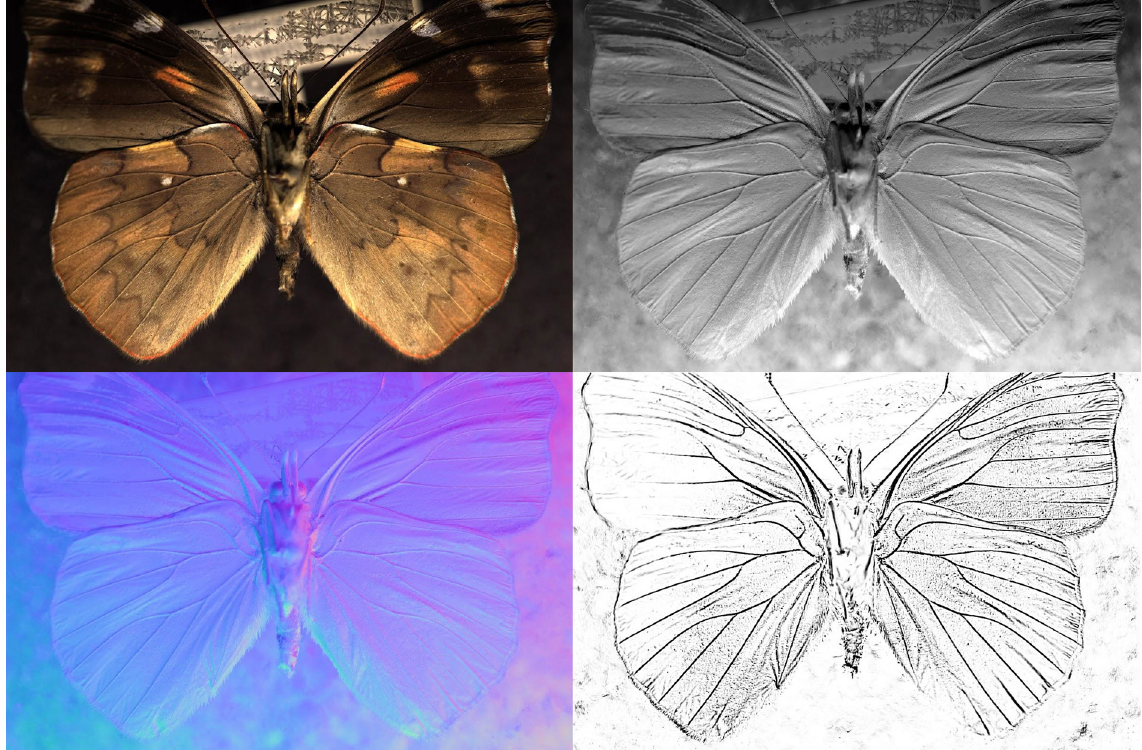
Fig. 2.31. Perisama cardases captured with PLD. The normal colour image with relighting option is found on the upper left. Upper right is the grey scale image, bottom left the normal map and bottom right algorithmically-generated sketch using a